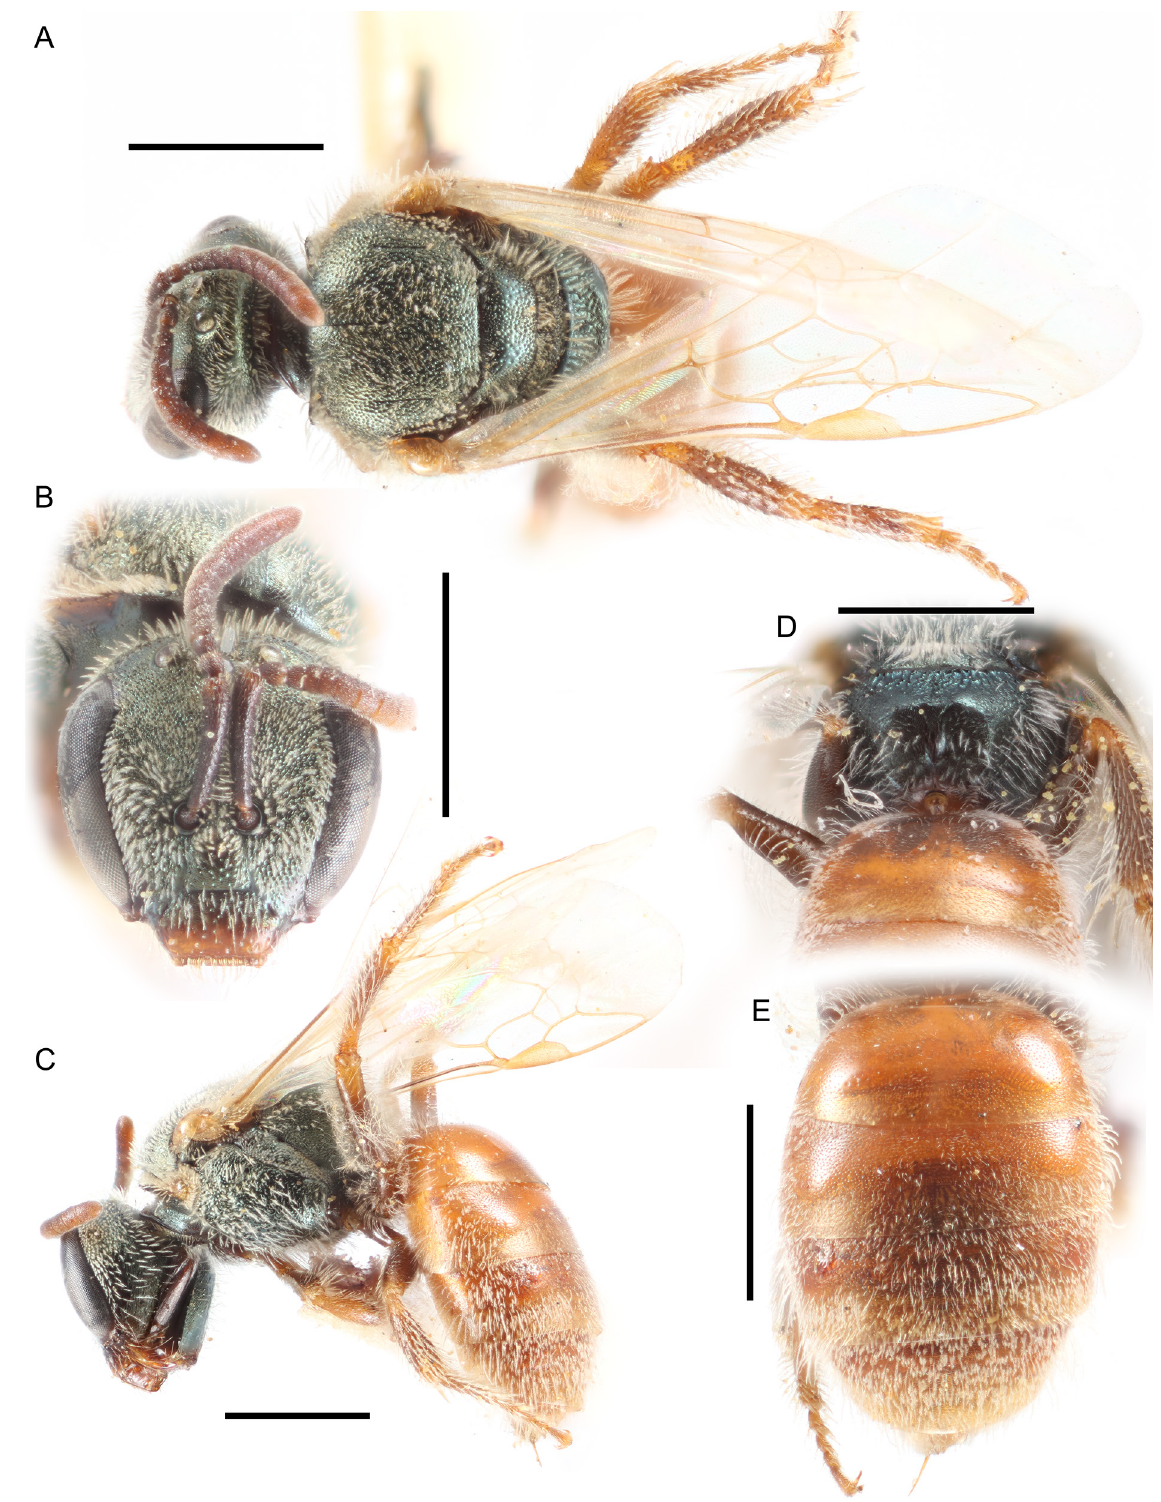
Fig. 8. Lasioglossum ( D. ) arenisaltans sp. nov., ♀. A . Dorsal habitus. B . Face. C . Lateral habitus. D . Propodeum. E . Metasoma. Scale bars: 1